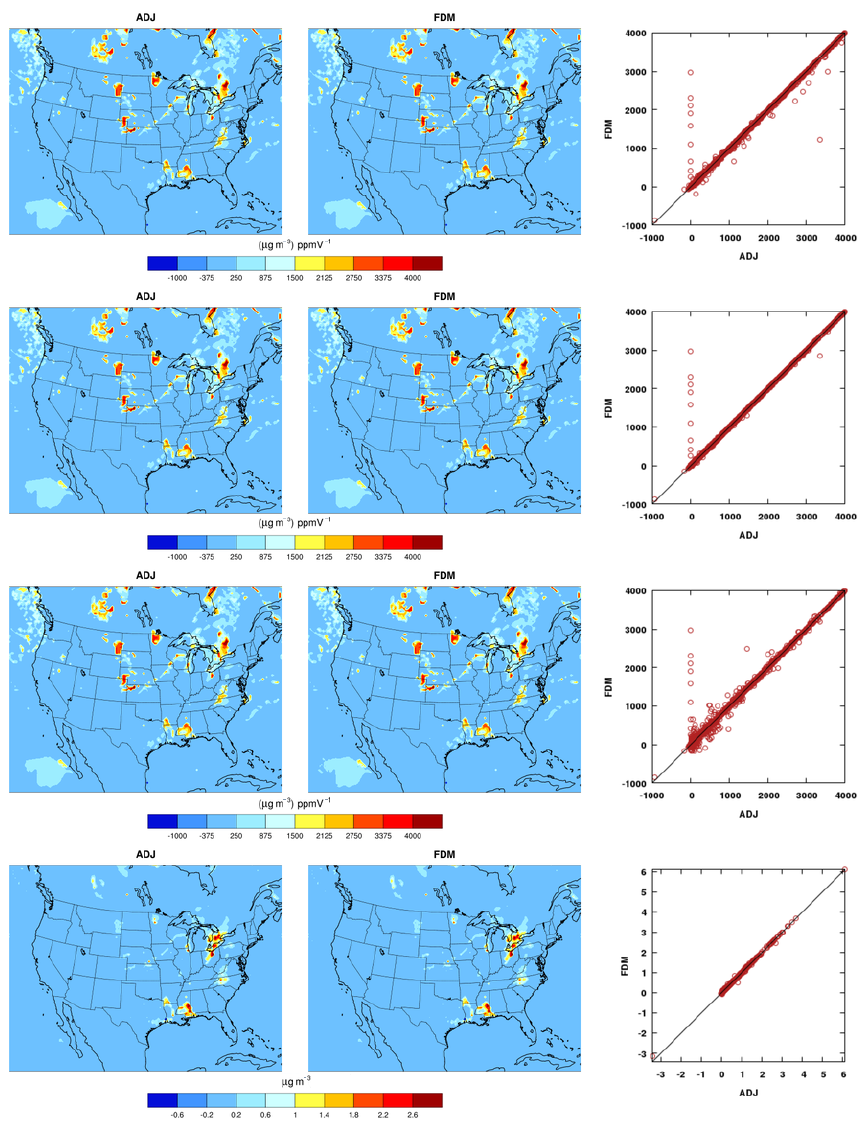
Figure 7. Evaluation of cloud dynamics and aqueous chemistry with the ADJ (adjoint) against the FDM (finite-difference method) sensitiv- ities of the final concentrations of an accumulation-mode aerosol species ASO4J (µgm − 3 ) with respect to the initial SO 2 (ppmV) from a 1d test run. The perturbation size for the FDM is 0.01, 0.001, and 0.0001ppb for the top three panels (from top to bottom). The bottom panel represents sensitivities semi-normalized by the initial conditions of SO 2 , and the perturbation size for the FDM is